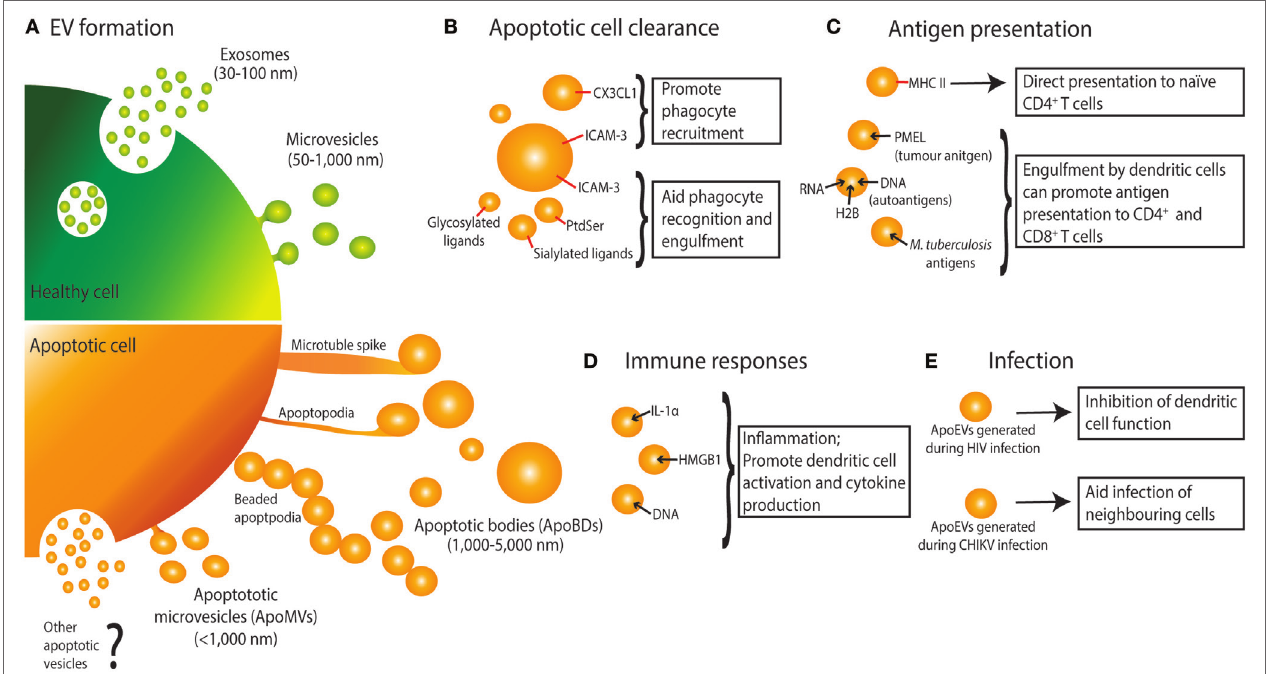
FiGURe 1 | Extracellular vesicle (EV) formation and immune functions of apoptotic cell-derived EVs (ApoEVs). (A) Healthy cells form two main types of EV, namely exosomes that are release via exocytosis of multivesicular bodies, and microvesicles that are shed from the plasma membrane. During apoptosis, dying cells can also release ApoEVs. Apoptotic cells can undergo morphological changes including membrane blebbing, thin membrane protrusion formation (microtubule spikes, apoptopodia, and beaded-apoptopodia), and generation of distinct apoptotic bodies (ApoBDs). Apoptotic cells can also release EVs that are similar in size as microvesicles (ApoMVs), however, it is unclear if ApoMVs are generated via the same mechanism as microvesicles from healthy cells. Whether apoptotic cells can generate vesicles that are similar to exosomes is undetermined. (B) ApoEVs can harbor “find-me” signals (e.g., CX3CL1 and ICAM-3) to attract phagocytic cells, as well as “eat-me” signals [e.g., ICAM-3, phosphatidylserine (PtdSer), and sialylated and glycosylated ligands] to promote uptake by phagocytes. (C) ApoEVs have MHC II molecules on their surface, which is essential for direct antigen presentation to naïve CD4 + T cells and activation of immunological memory. ApoEVs can also carry antigen to professional antigen-presenting cells (e.g., dendritic cells). Antigens carried by ApoEVs include autoantigens, tumor antigens, and microbial antigens. (D) ApoEVs can promote inflammation by transporting proinflammatory cytokines such as IL-1 α and damage-associated molecular patterns including DNA and HMGB1. (e) ApoEVs can aid HIV infection by inhibiting dendritic cell activation. Chikungunya virus (CHIKV) can hijack ApoEVs to propagate infection to neighboring